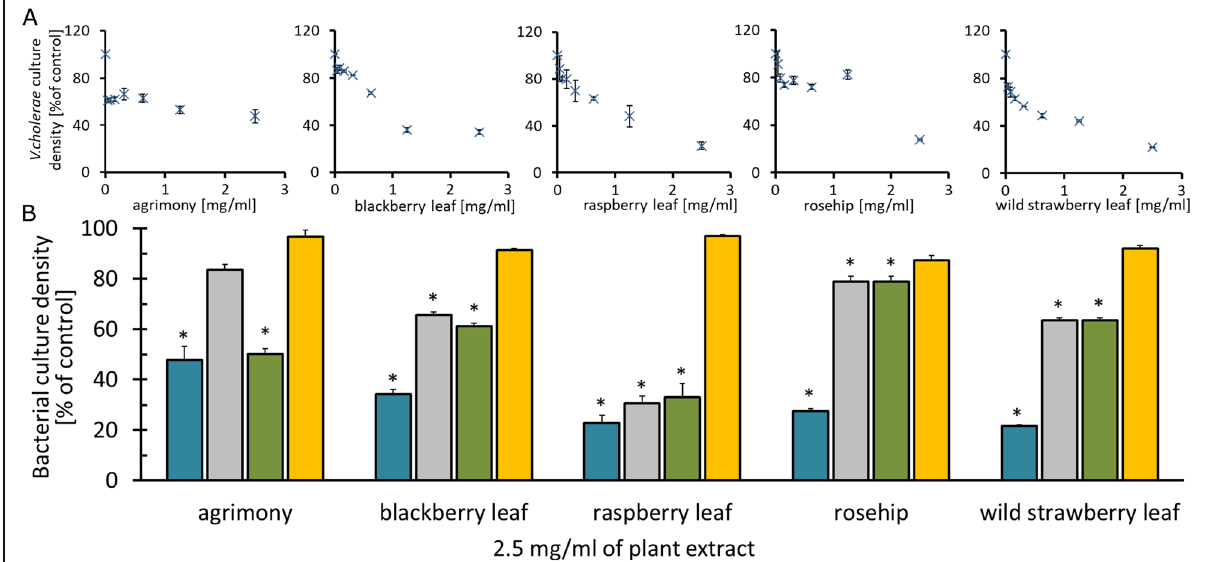
Fig. 1 Bacteriostatic properties of plant extracts. a Density of 18 h V. cholerae cultures as a function of incubation with different plant extract concentrations (0 – 2.5 mg/mL); b Culture density after 18 h incubation of four bacterial strains: V. cholerae (blue), E. coli ATCC 25922 (grey), E. coli O44 (green) and L. rhamnosus (yellow) with 2.5 mg/mL aqueous extracts of plant extracts. Values are mean ± standard errors of three independent assays. * p < 0.05, compared with untreated bacterial cultures